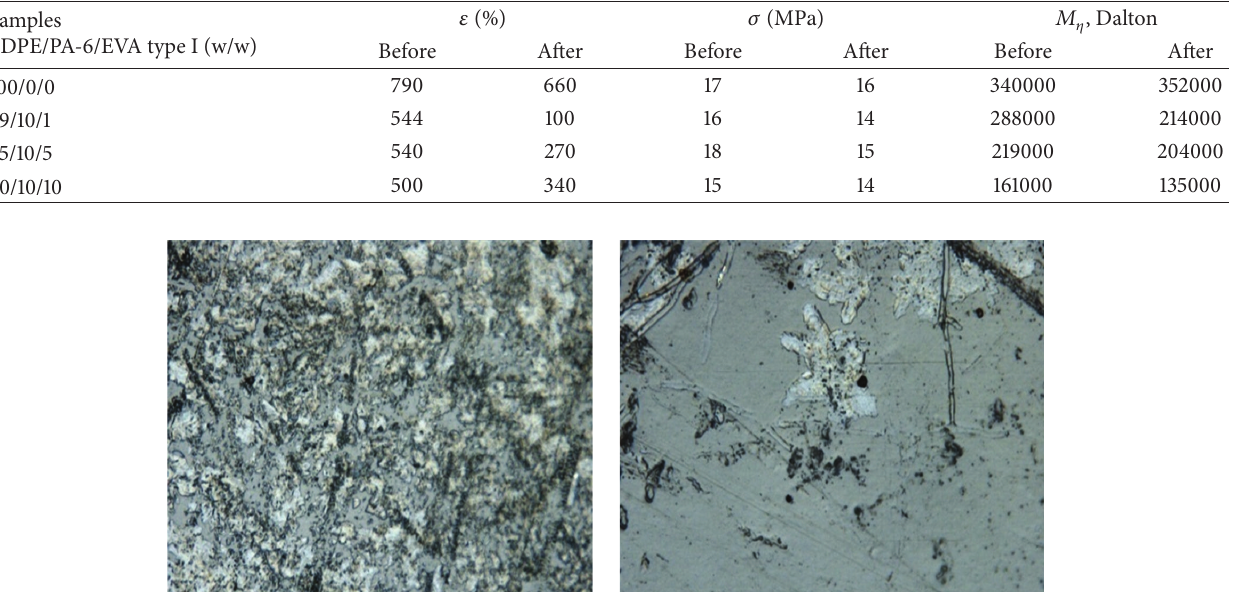
Table 4: Some characteristics of polymeric compositions before and after biodegradation for 28 days.